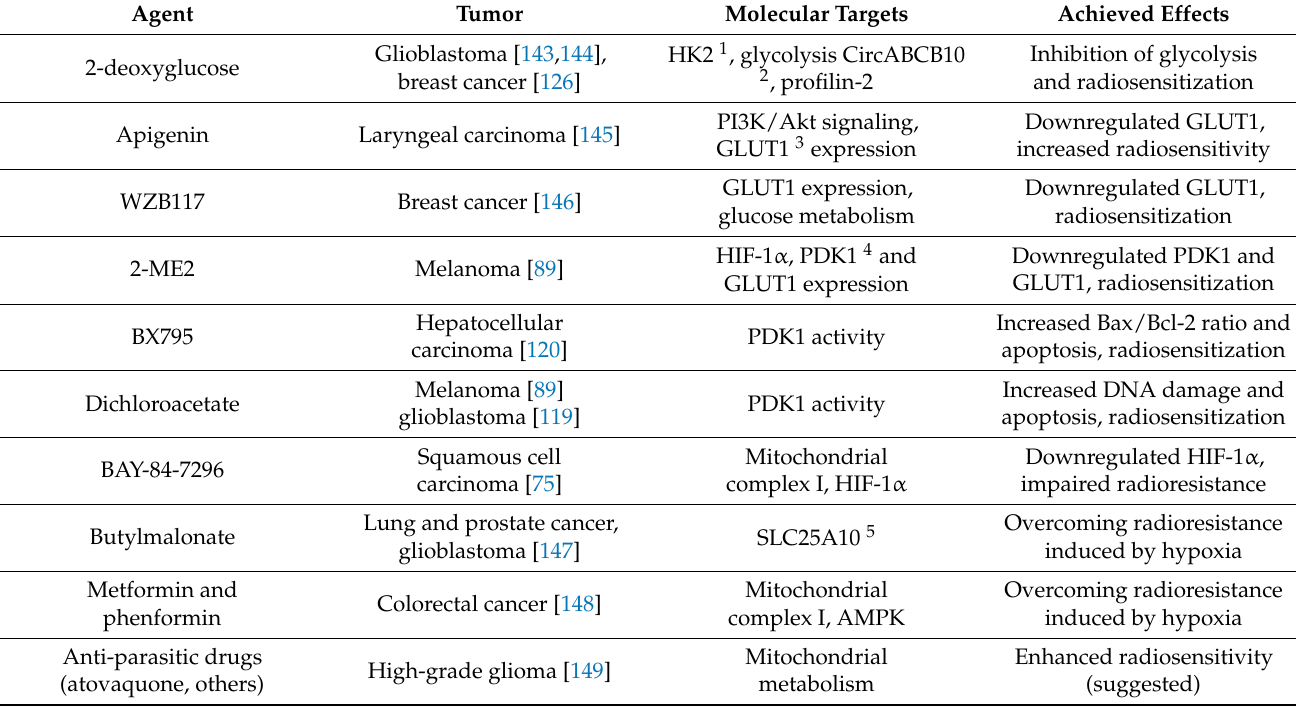
Table 2. Small molecule radiosensitizers targeting the energy metabolism in tumor